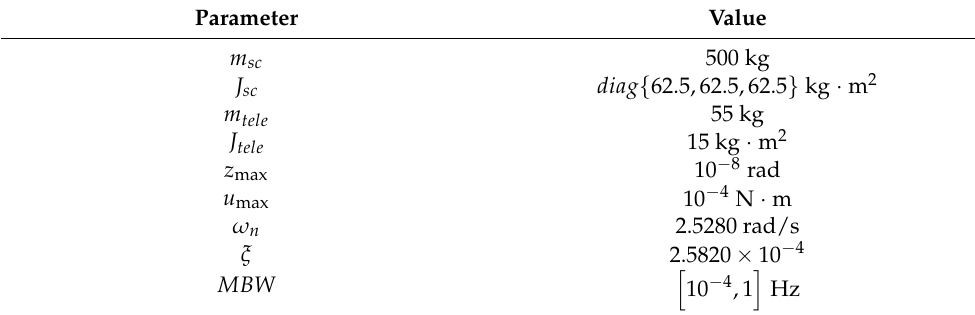
Table 2. Simulation